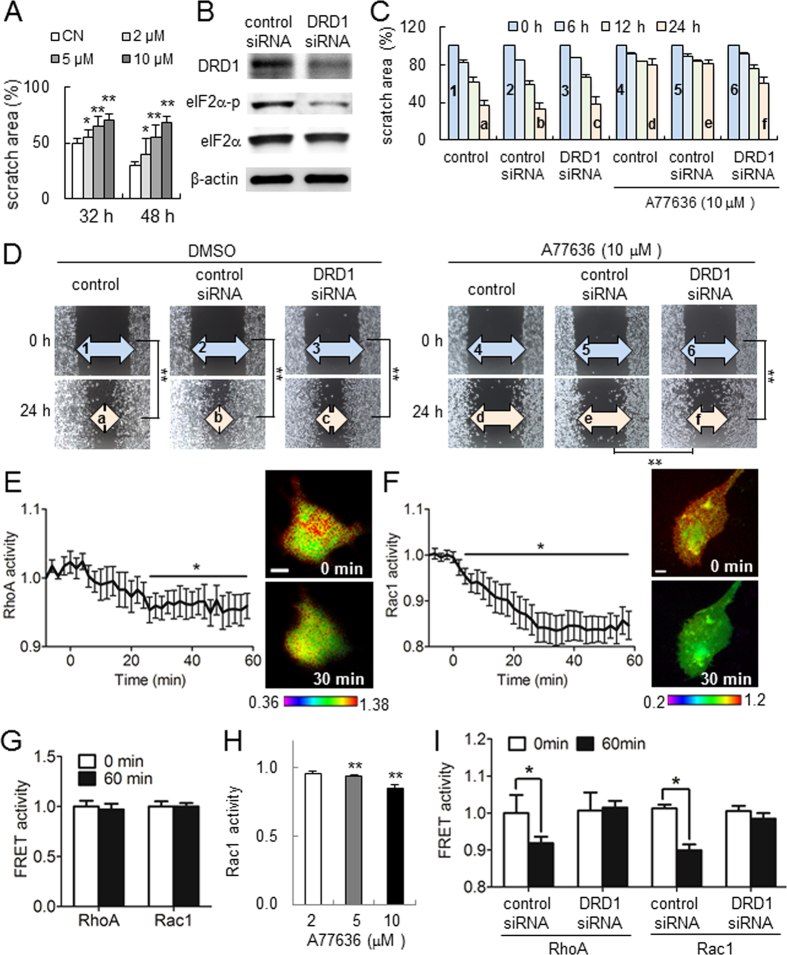
Inhibitory effects of A77636 on the migration of MD231 cells.The single and double asterisks indicate p < 0.05 and p < 0.01, respectively. (A) Dose-dependent suppression of cellular migration in response to 2, 5, and 10 μM A77636. Of note, CN = control. (B) Partial silencing of dopamine receptor D1 (DRD1) with DRD1 siRNA. (C,D) Wounded area with and without DRD1 siRNA in the presence and absence of 10 μM A77636. The double asterisk indicates p < 0.01. (E,F) FRET-based activities of RhoA and Rac1 GTPases, respectively, in response to 10 μM A77636. (G) Stationary FRET-based baseline activities of RhoA and Rac1 GTPases in the absence of A77636. (H) Rac1 activity after 1 h treatment with 1, 5, and 10 μM A77636. (I) FRET-based RhoA and Rac1 activities in the presence and absence of DRD1 siRNA in response to 10 μM A77636.